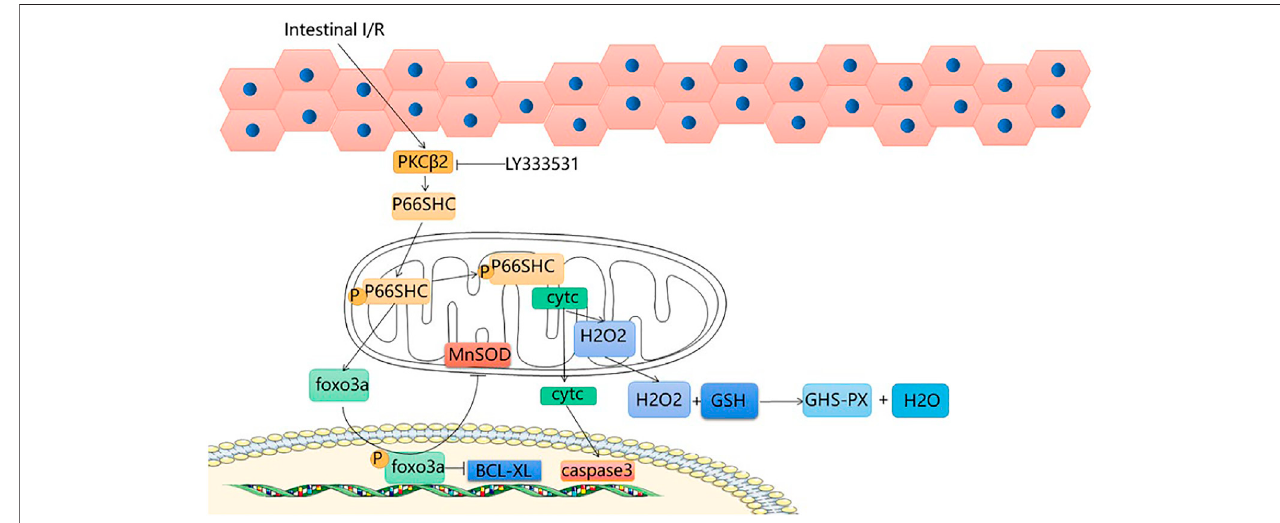
FIGURE 2 | P66shc signaling pathway.